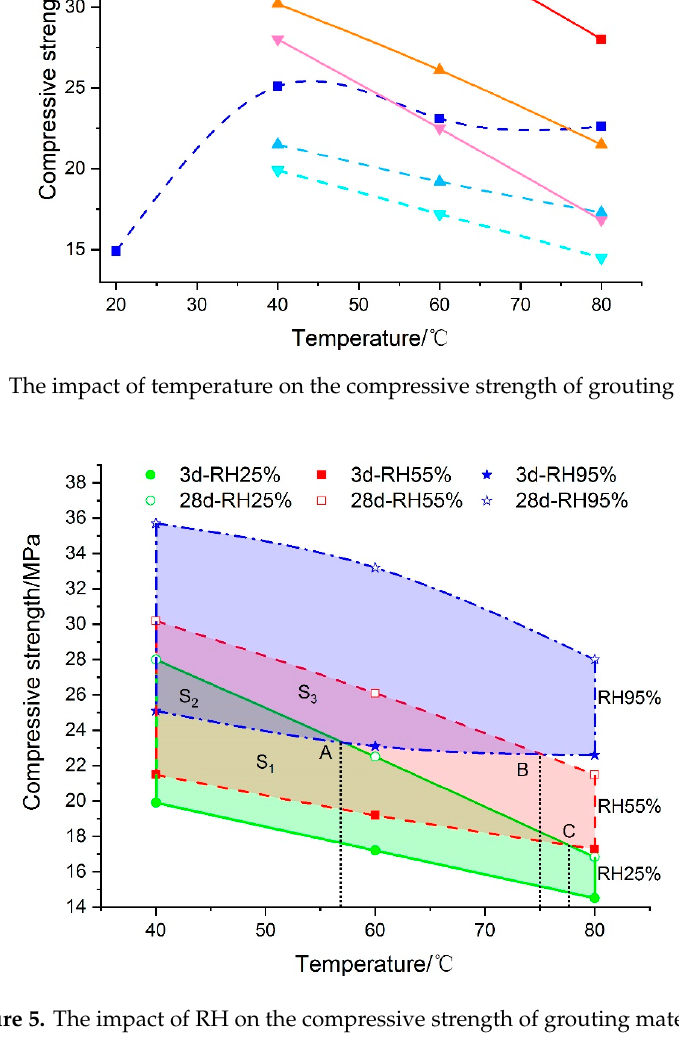
Figure 4. The impact of temperature on the compressive strength of grouting material.